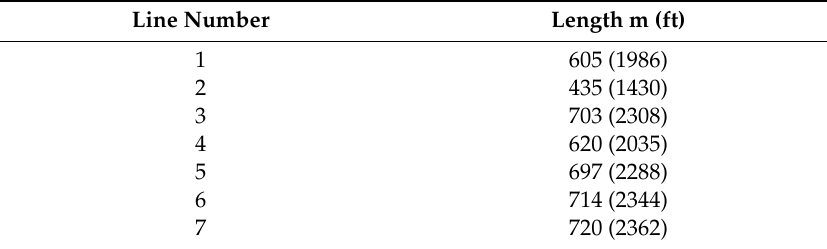
Table 1. Length of the survey